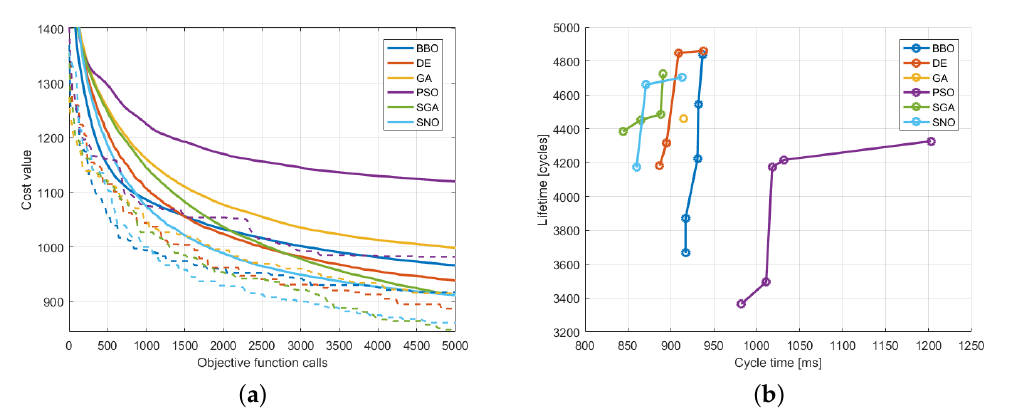
Figure 8. Comparison of the algorithms in terms of convergence curves and Pareto fronts. ( a ) Comparison of convergence curves. ( b ) Comparison of Pareto fronts.